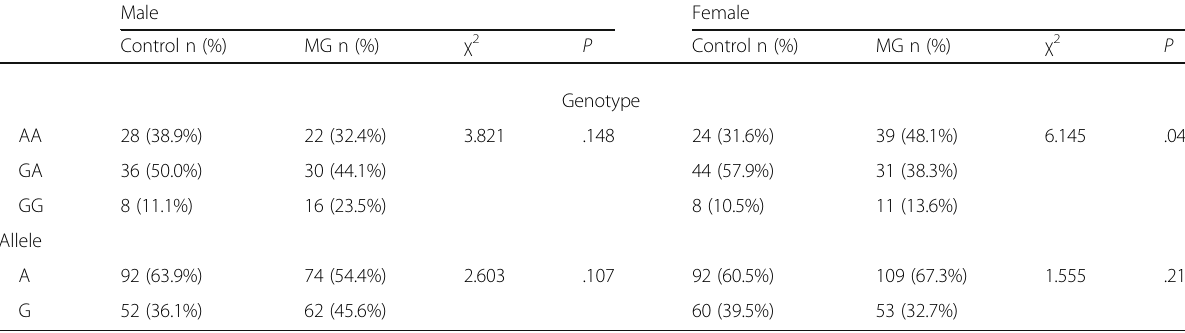
Table 2 Genotype and allele frequencies of BAFF rs2893321 in male or female subjects